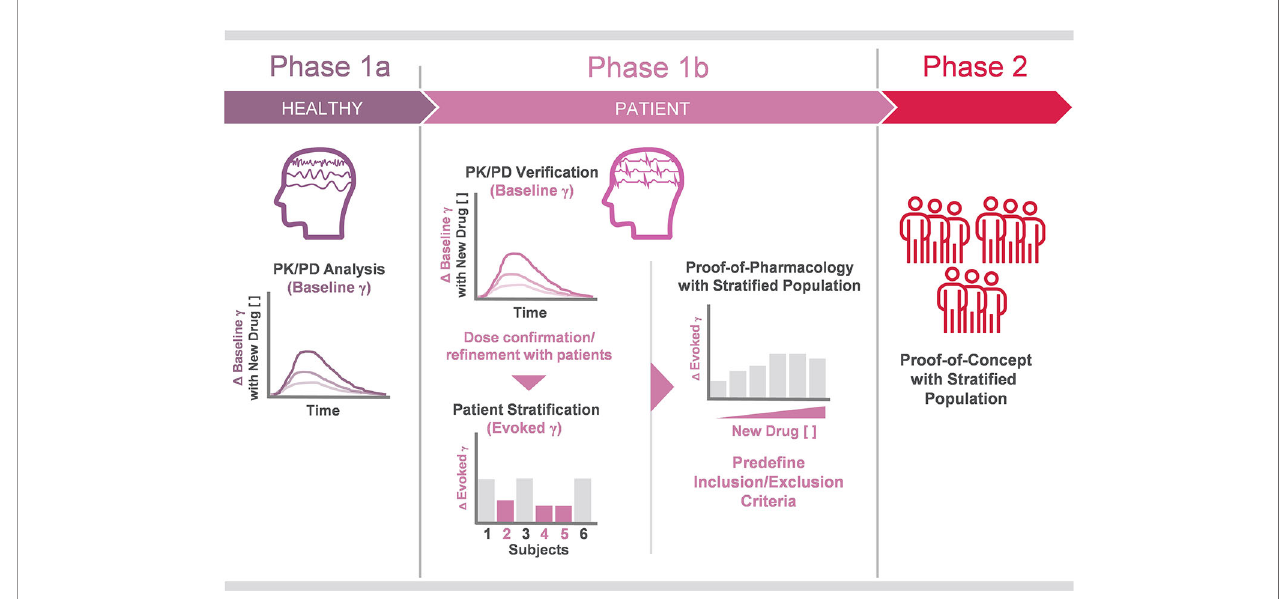
FIGURE 1 | Proposed work fl ow of gamma oscillation analysis in future clinical trials. Phase 1a PK/PD analysis of investigational drugs targeting E/I imbalance. In the proposed trial design, baseline gamma alterations are tracked against investigational drugs concentrations in plasma, receptor occupancy, etc., in healthy volunteers. These results are con fi rmed in the patient population prior to stage-up. Phase 1b also includes patient population strati fi cation, achieved in part by identi fi cation of blunted evoked gamma in ASSR testing. Phase 2 trial design is informed on dosing and time course insights gained in Phase 1a/b PK/PD testing, while candidate patient populations are de fi ned (Phase 1b) before therapeutic response is evaluated using evoked gamma ASSR and other clinical endpoints in Phase